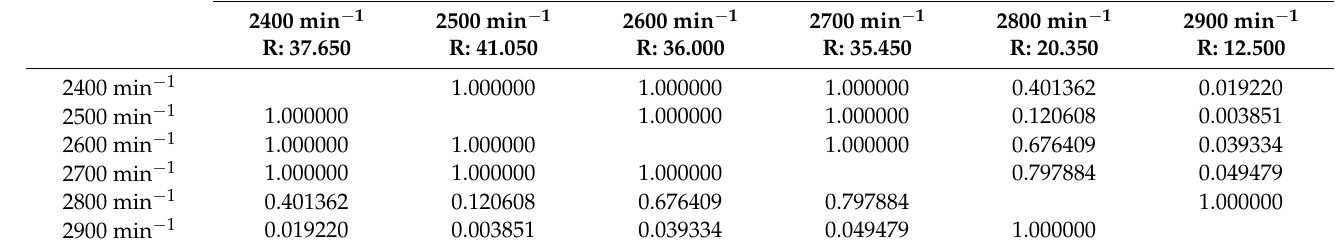
Table 3. Results of multiple comparisons of p values of the number of drilled holes up to the moment of tool damage in terms of speed.